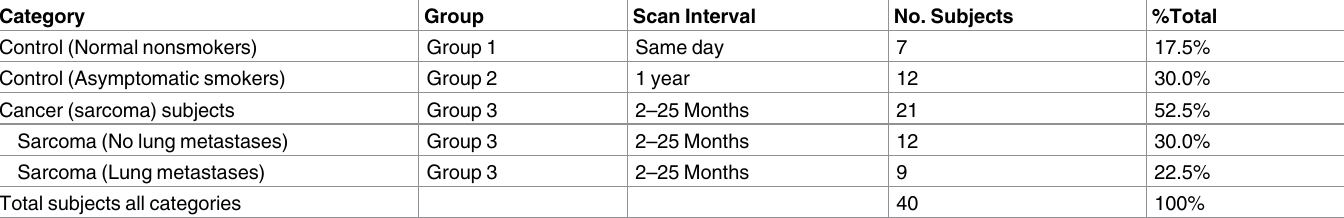
Table 1. Human subjects: Two control groups and